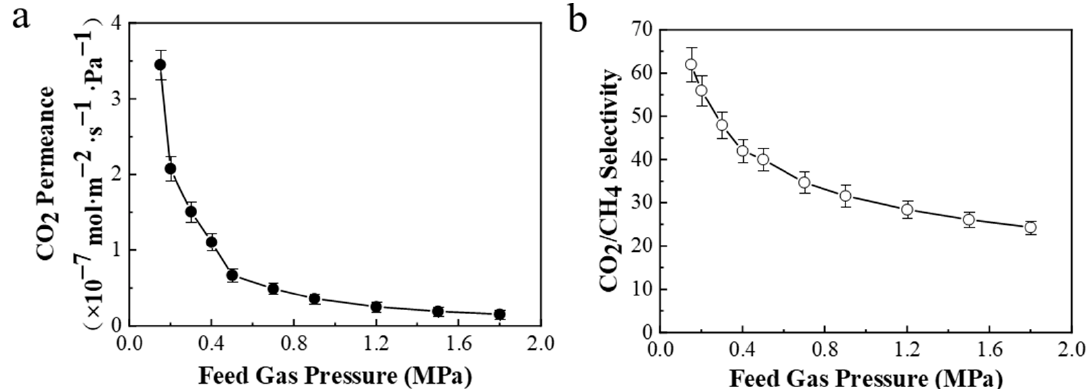
Figure 10. Effect of the feed gas pressure on the CO 2 /CH 4 mixed gas separation performance of PPPS/PDMS/PSf composite membrane. ( a ), the pressure-dependent CO 2 permeance of the PPPS/PDMS/PSf membrane. ( b ), the correspond- ing CO 2 /CH 4 selectivity of the PPPS/PDMS/PSf membrane varying with feed pressure. Test conditions: 298 K and saturated